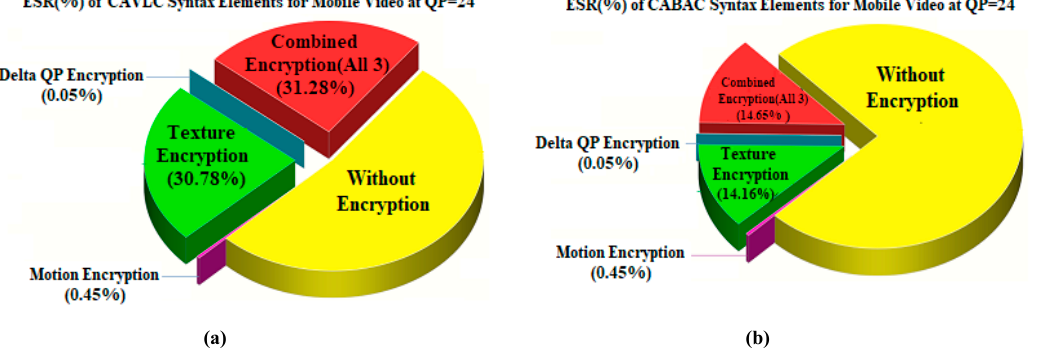
Figure 4. Comparison of calculated ESR over ( a ) CAVLC and ( b ) CABAC syntax elements of mobile video.